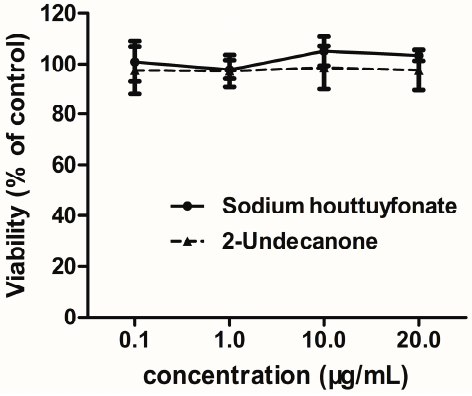
Figure 1. Effects of drugs on cell viability determined by the thiazolyl blue (MTT) assay. Data are expressed as means ± standard deviation